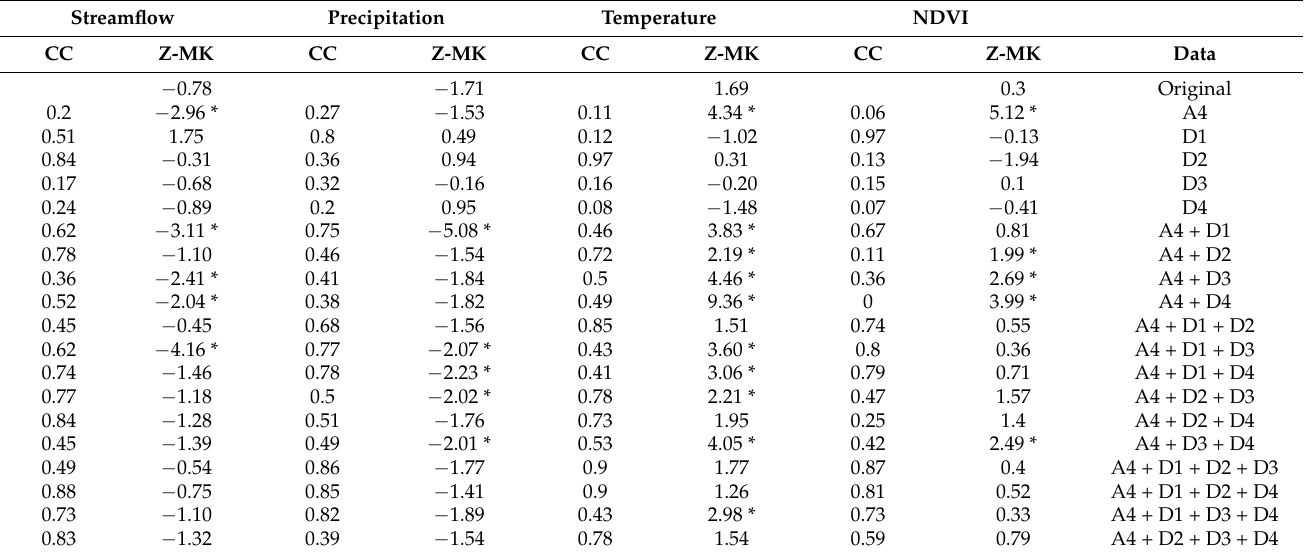
Table 3. Mann–Kendall Z-values and correlation coefficients of seasonal time series—Nazloo-Chay.